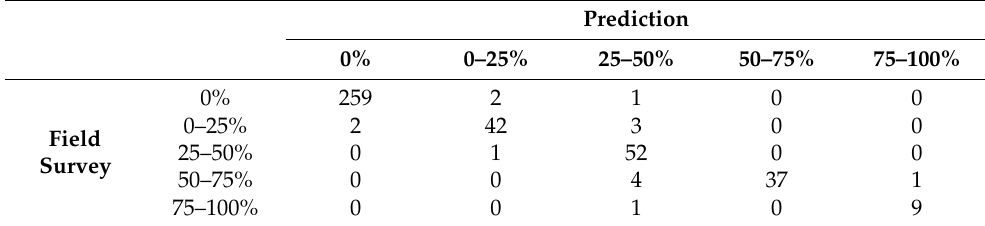
Figure 12. Comparison of ( a ) the collapsed ratio in the report of the field survey [42] and ( b ) our prediction in a 57-m grid unit. Table 7. Confusion matrix of grid prediction in the whole investigated